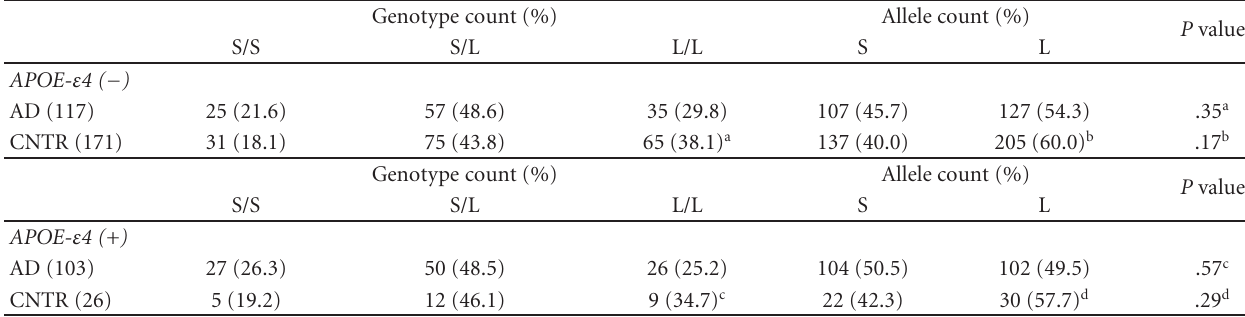
Table 4: Stratification of 5-HTTLPR genotype according to APOE- ε 4